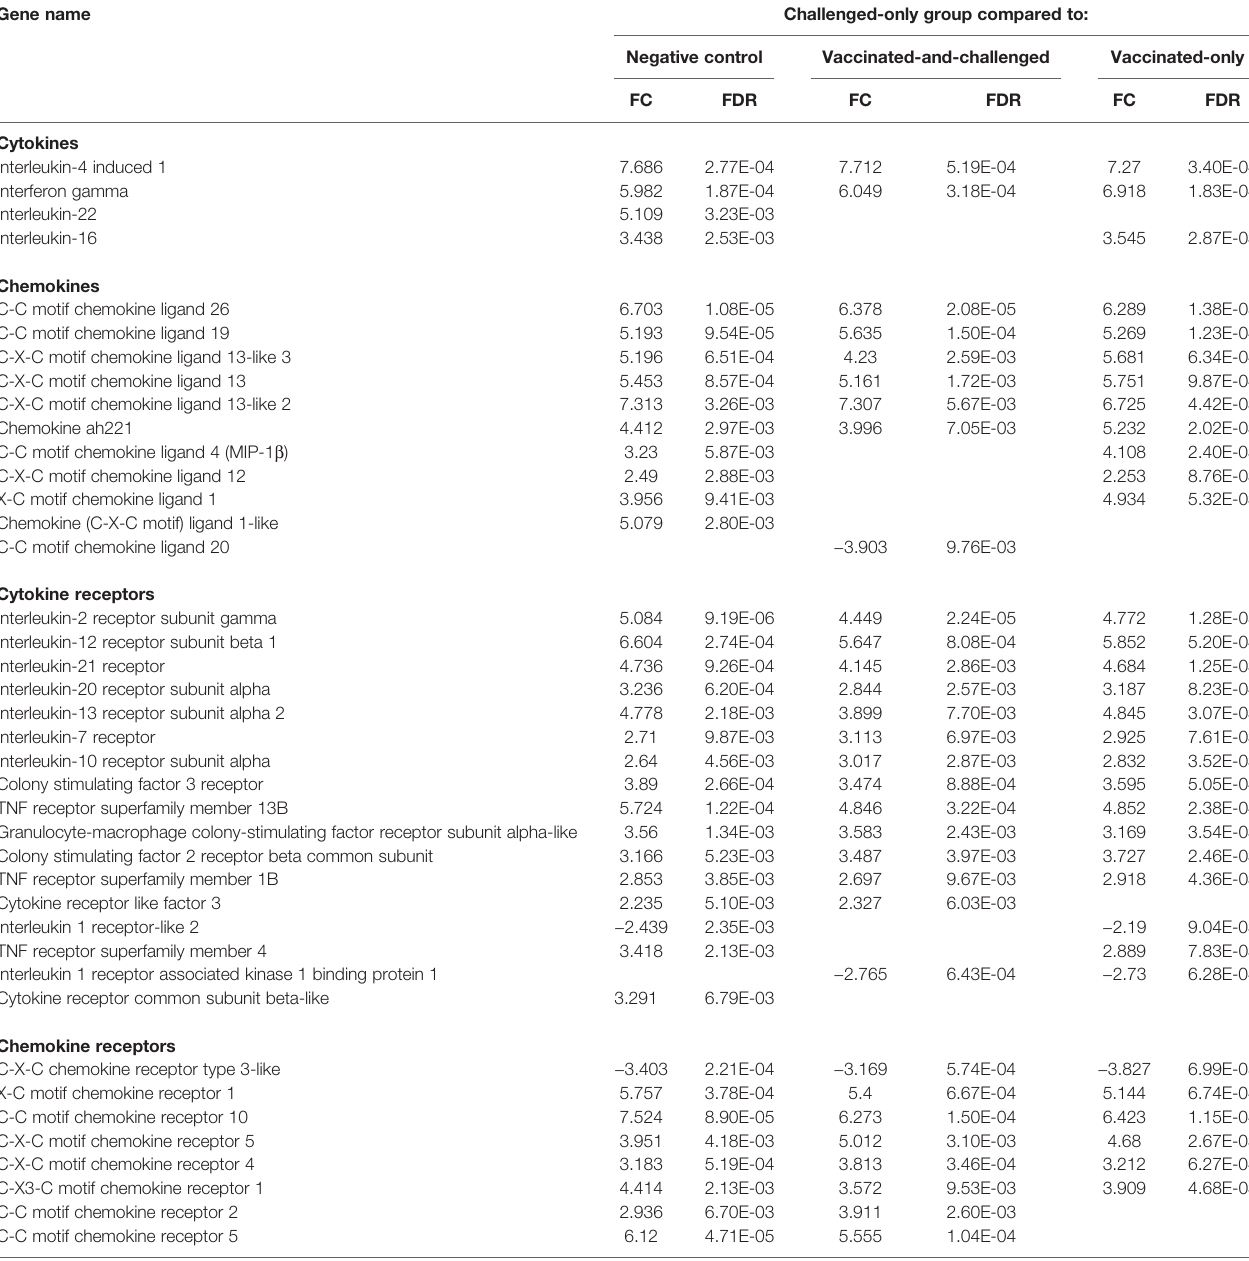
TABLE 3 | Log 2 fold changes (FC) and false discovery rates (FDR) of differentially expressed genes for cytokines, chemokines and their receptors in the challenged-only group compared to the other groups. Gene name Challenged-only group compared to: Negative control